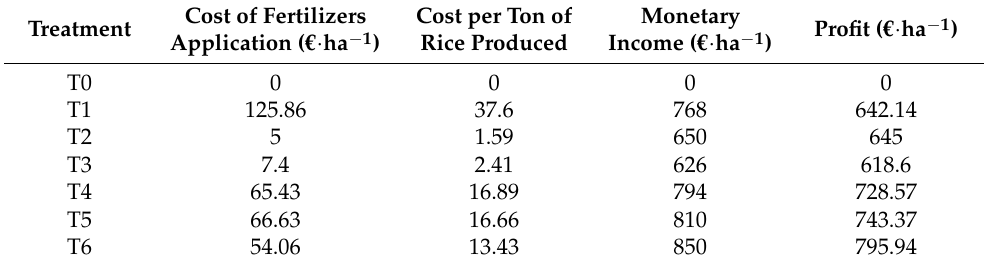
Table 8. Economic